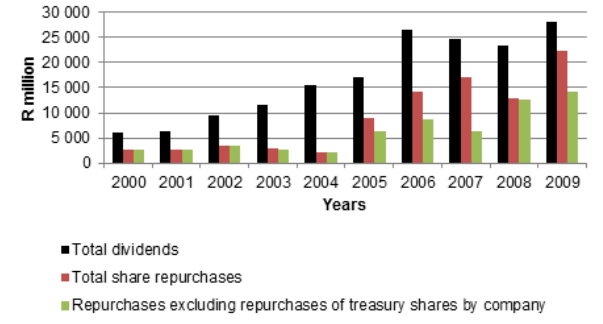
Figure 4: Share repurchases versus dividends based on value (adjusted to reflect 1999